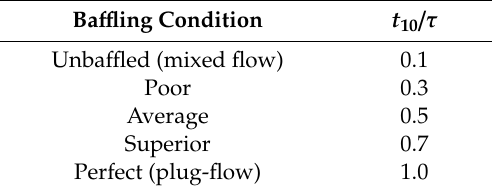
Table 2. Ba ffl ing classification according to the t 10 / τ index Table 2. Baffling classification according to the t 10 / τ index [31].